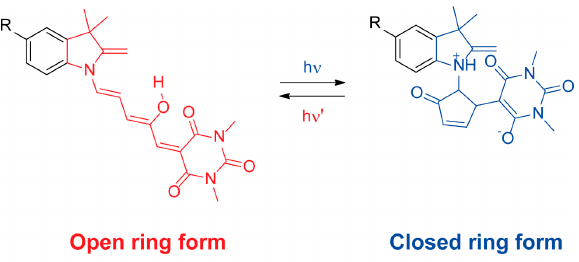
Figure 10. Reversible photoisomerization of a donor-acceptor Stenhouse adduct: from its open ring form (shown in red) to its closed ring form (shown in blue).